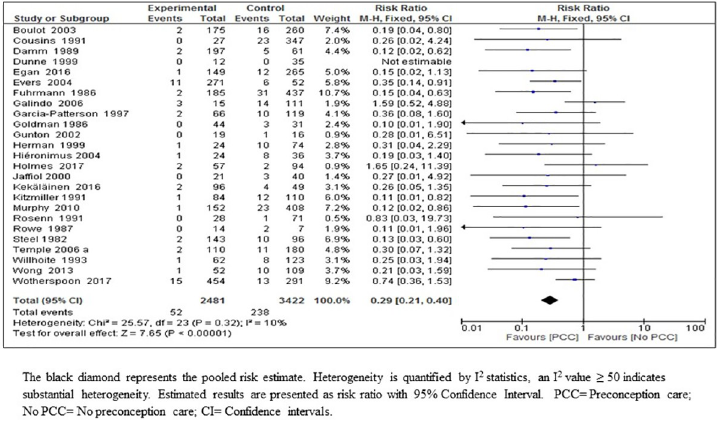
Fig 3. Risk ratio for congenital malformations from 25 studies of women with pre-existing diabetes mellitus who did or did not receive preconception care.